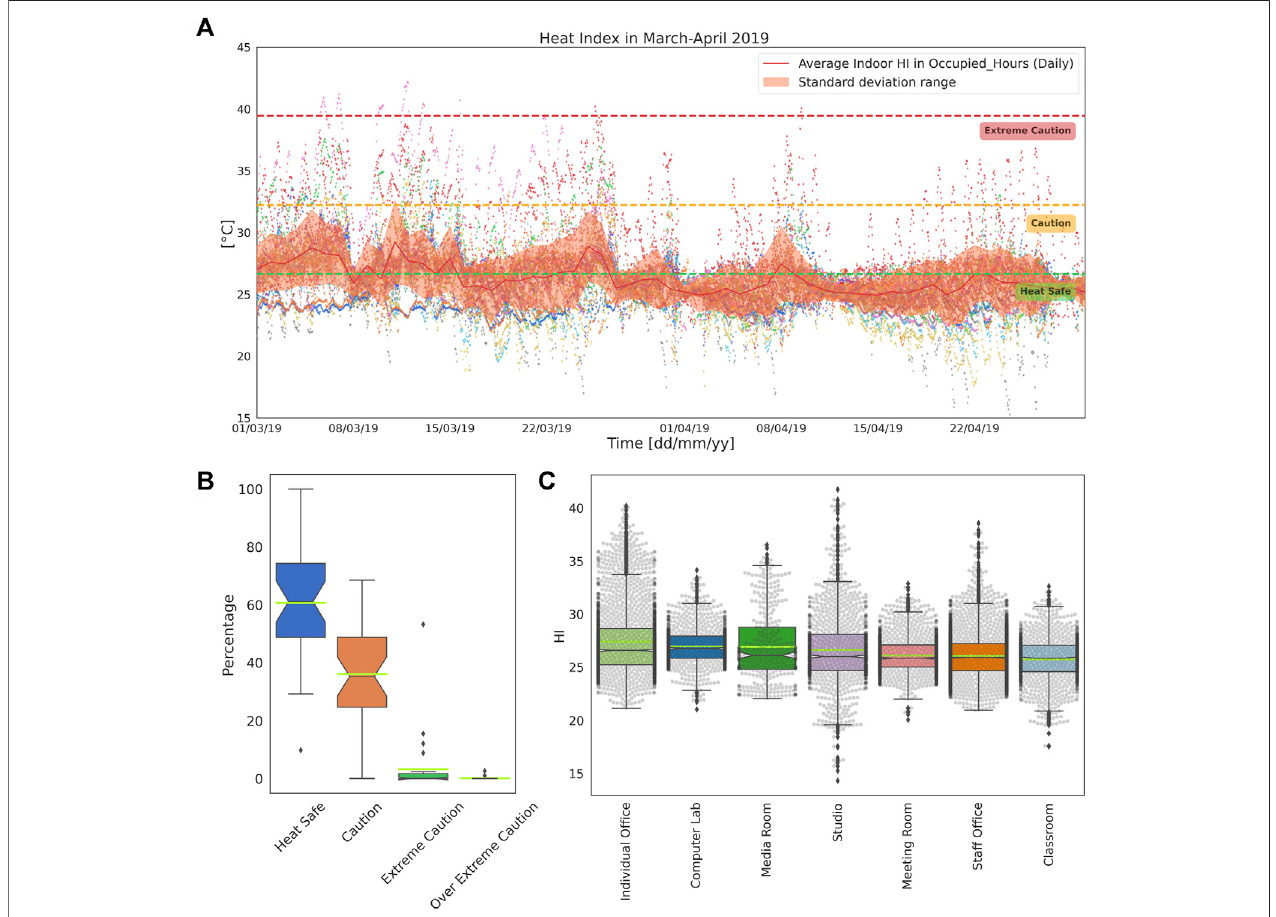
FIGURE 7 | Heat index analysis: (A) time trends between March and April 2019; (B) boxplot of occurrences under different health risk levels and (C) box and swarmplots of HI level broken down by room type, both showing mean observations, on hourly basis.